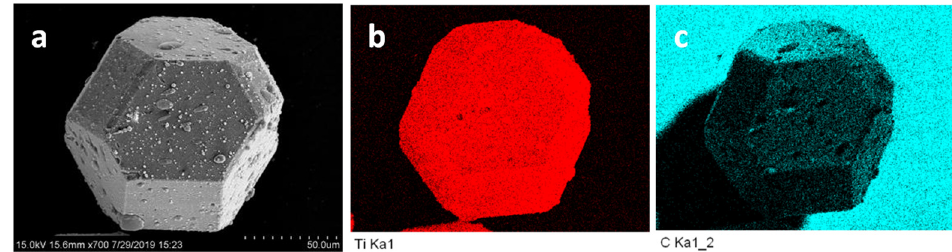
Figure 3. ( a ) SEM image of Ti-coated diamond particle for subsequent element mapping and ( b , c ) EDS mapping of Ti and C, respectively.